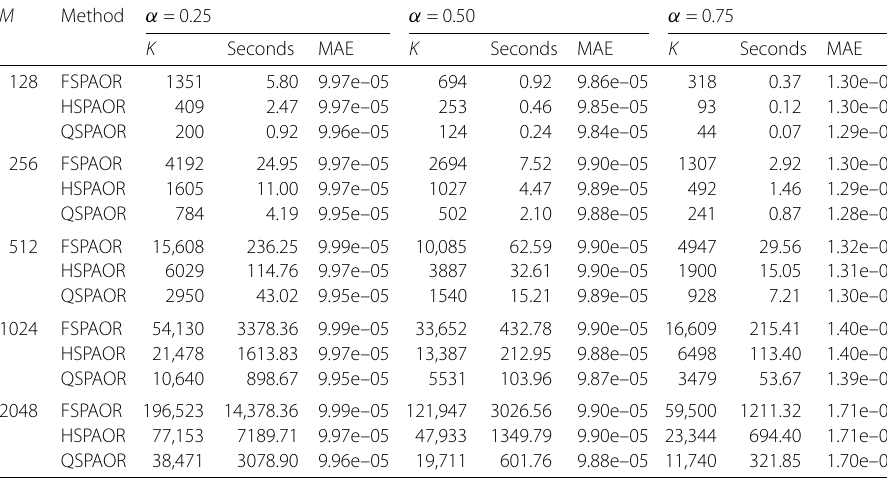
Table 1 Numerical results for Example 1